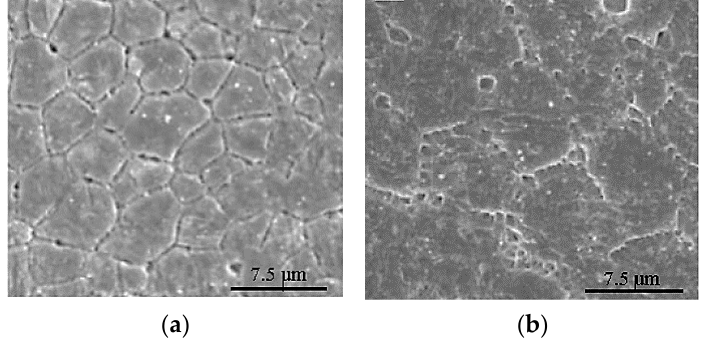
Figure 5. SEM images showing an increase in grain sizes when the laser power is increased (constant scan speed), ( a ) P = 300 W ( b ) P = 500 W [53].